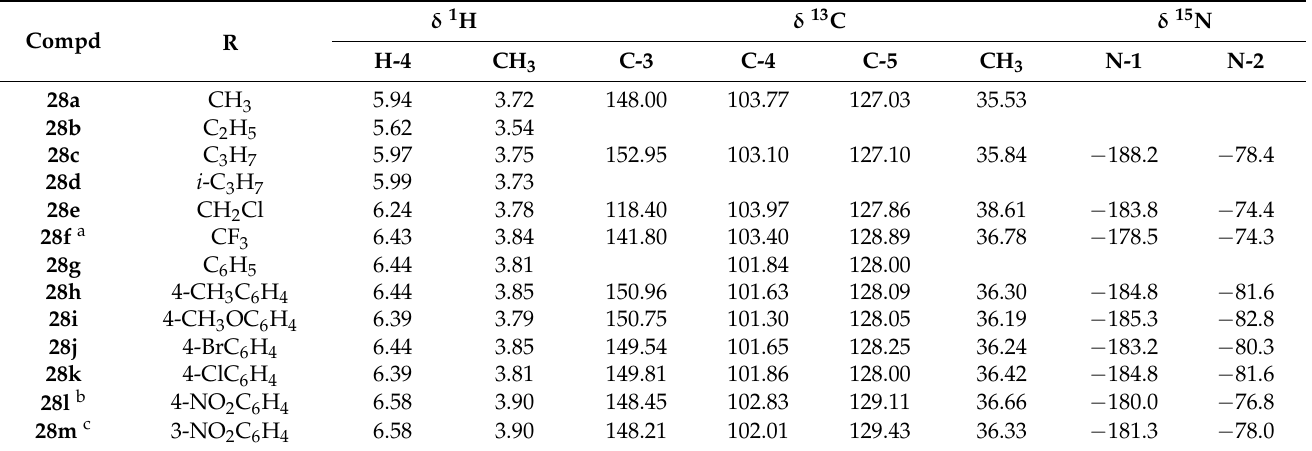
Table 3. 1 H, 13 C and 15 N NMR chemical shifts of 3-substituted 1-methyl-5-chloropyrazole 28 (ppm, CDCl 3